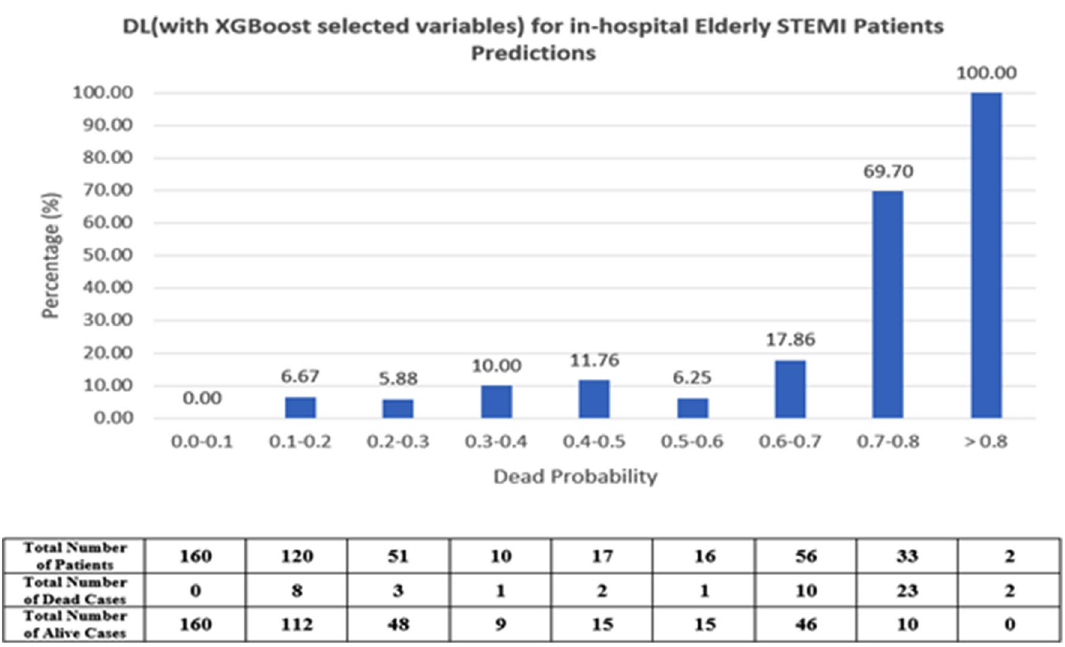
Figure 4. Mortality rate distribution on the validation set of DL (using XGBoost variables) model.